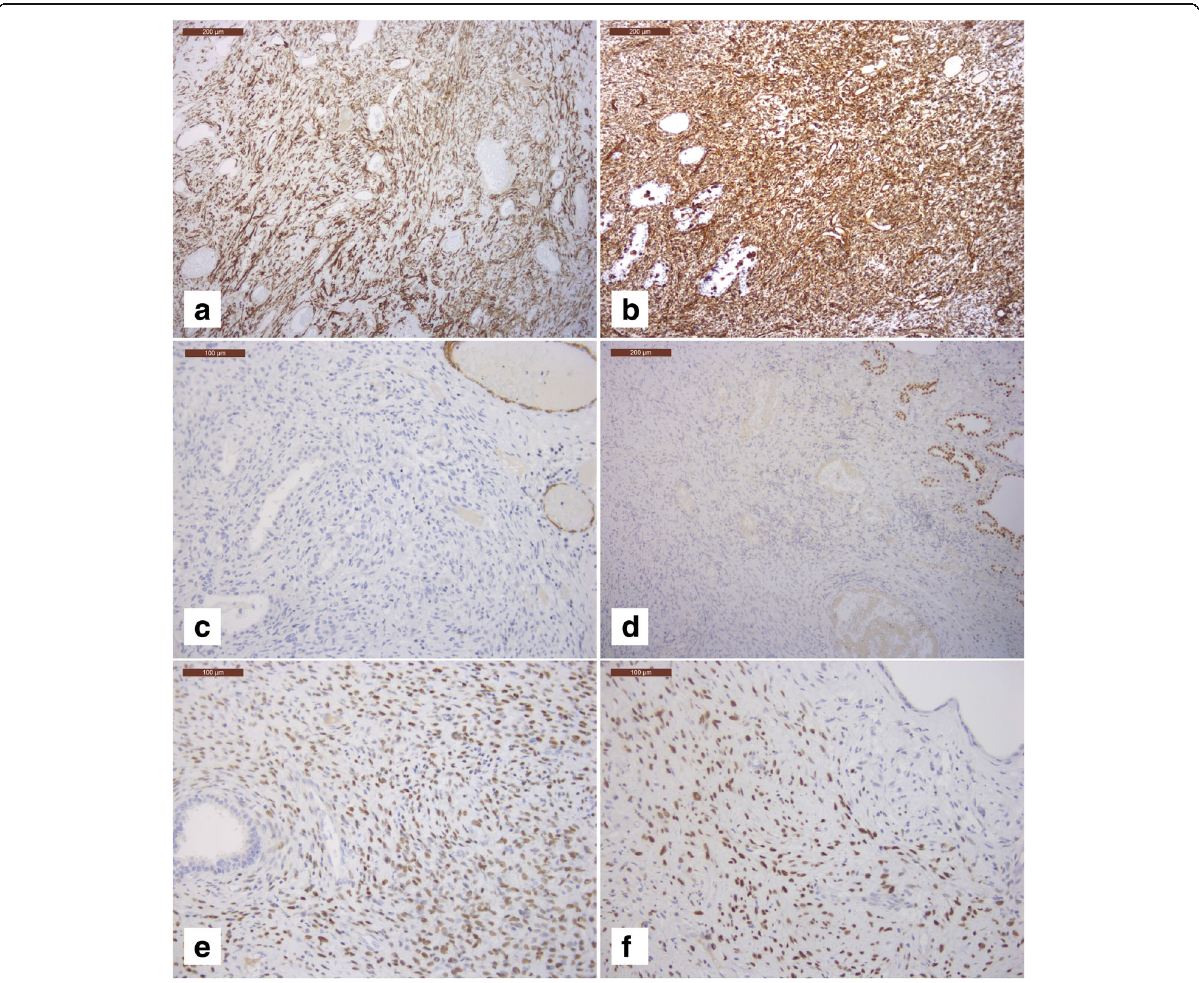
Fig. 3 Neoplastic cells showed patchy and intense immunoreactivity for CD10 ( a , 100×), diffuse vimentin staining ( b , 100×), negative staining for H-Caldesmon (positive control staining in small vessels;upper left) ( c , 100×), negative staining for TTF-1 (positive nuclear staining in the entrapped epithelial alveolar elements; right) ( d , 100×), moderately diffuse nuclear staining for estrogen receptor ( e , 200×), moderately diffuse nuclear staining for progesterone receptor ( f ,